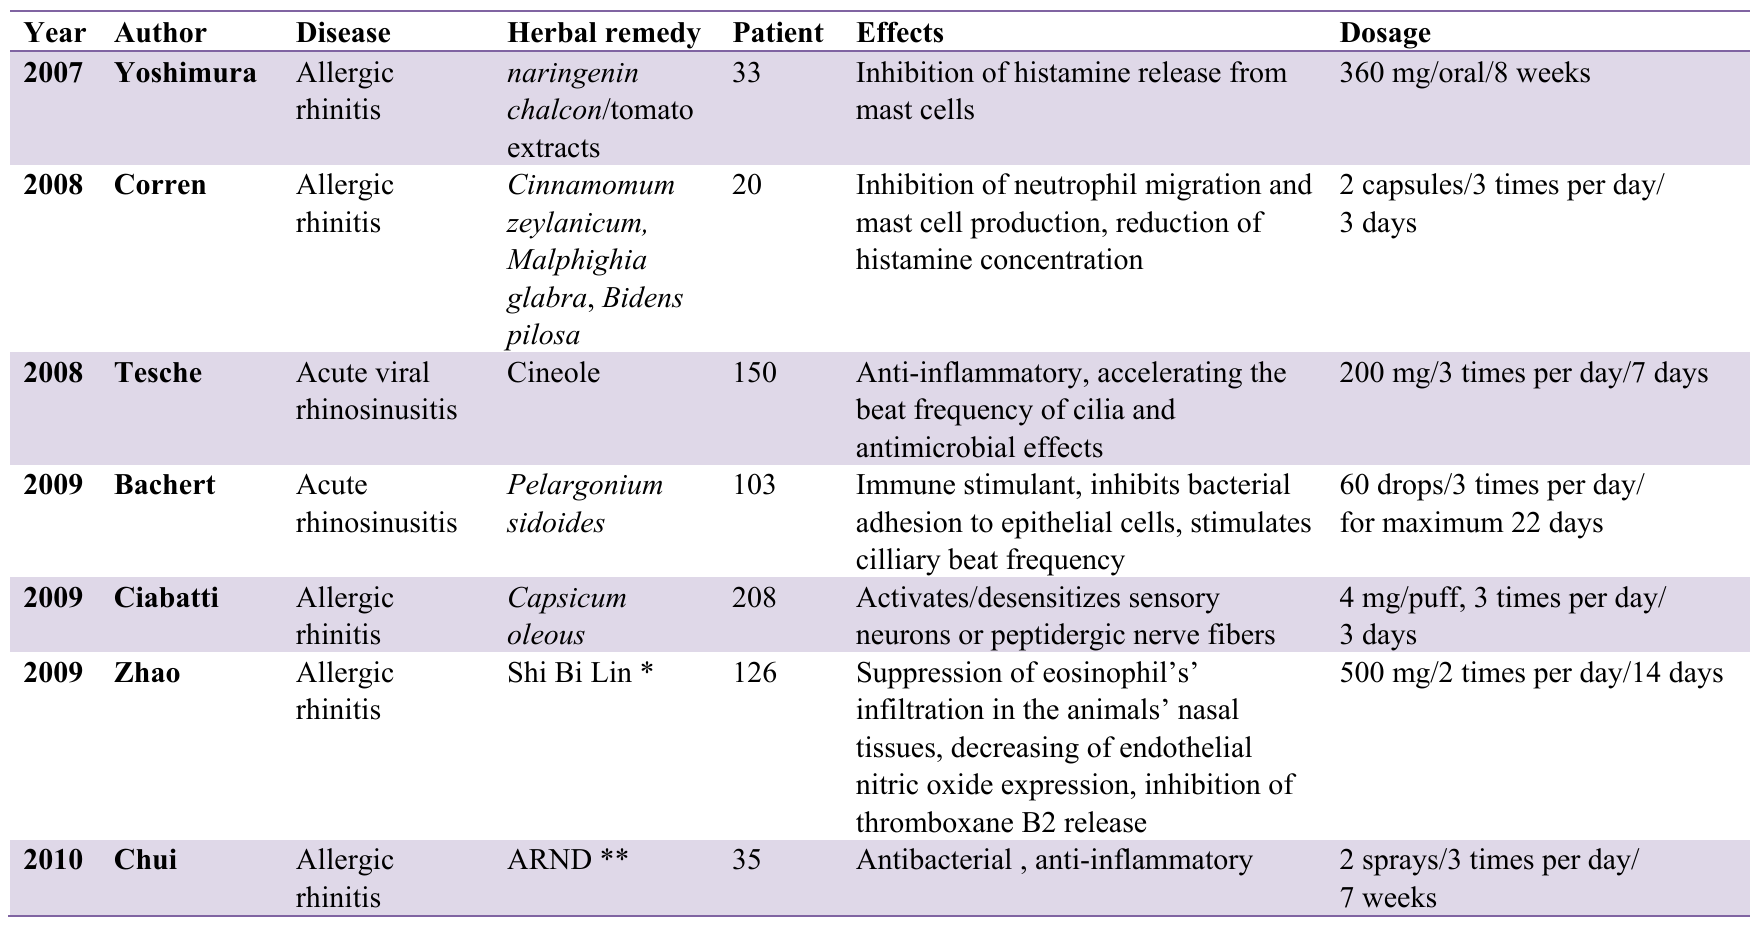
Table 1. Herbal remedies in the treatment of allergic rhinitis and acute